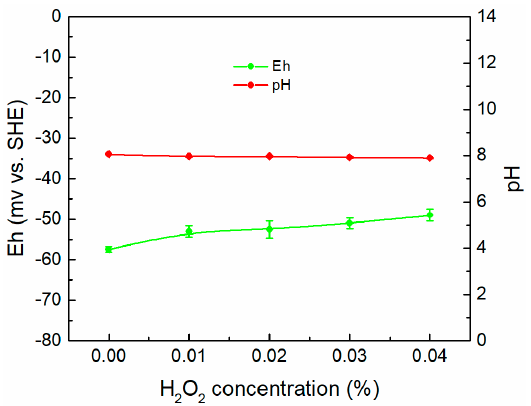
Figure 4. Variations on Eh and pH as a function of H 2 O 2 concentration. Error bars represent the standard deviation between duplicate tests.